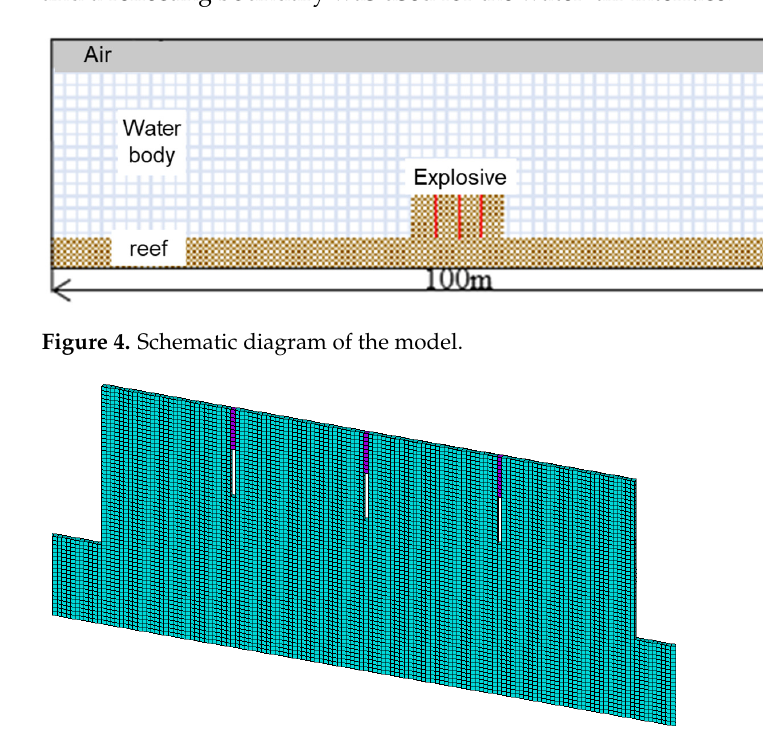
Figure 5. Schematic diagram of reef grid division.